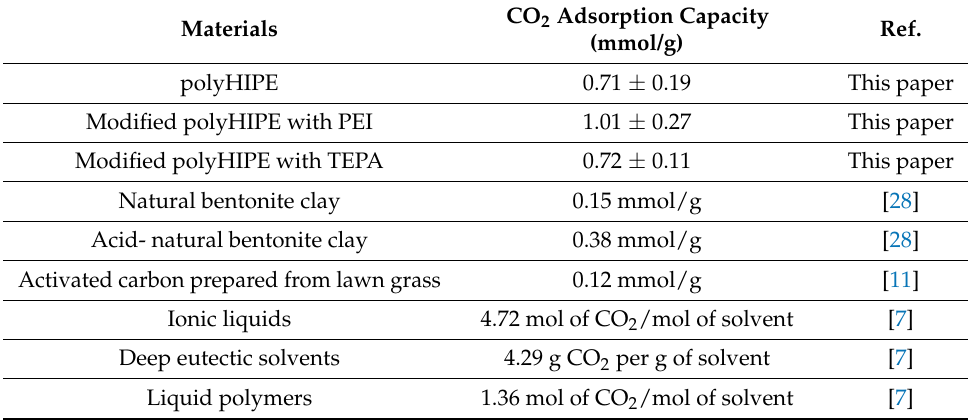
Table 3. CO 2 adsorption with different